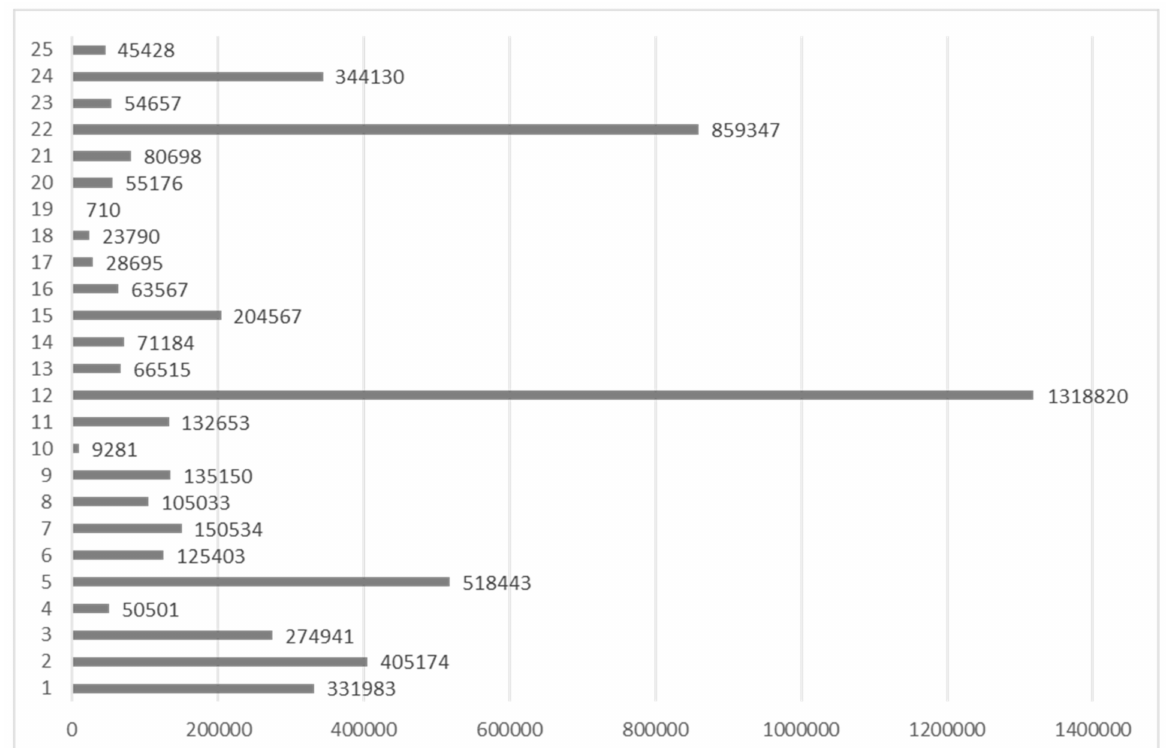
Figure 2. Total savings per city–electricity distribution costs